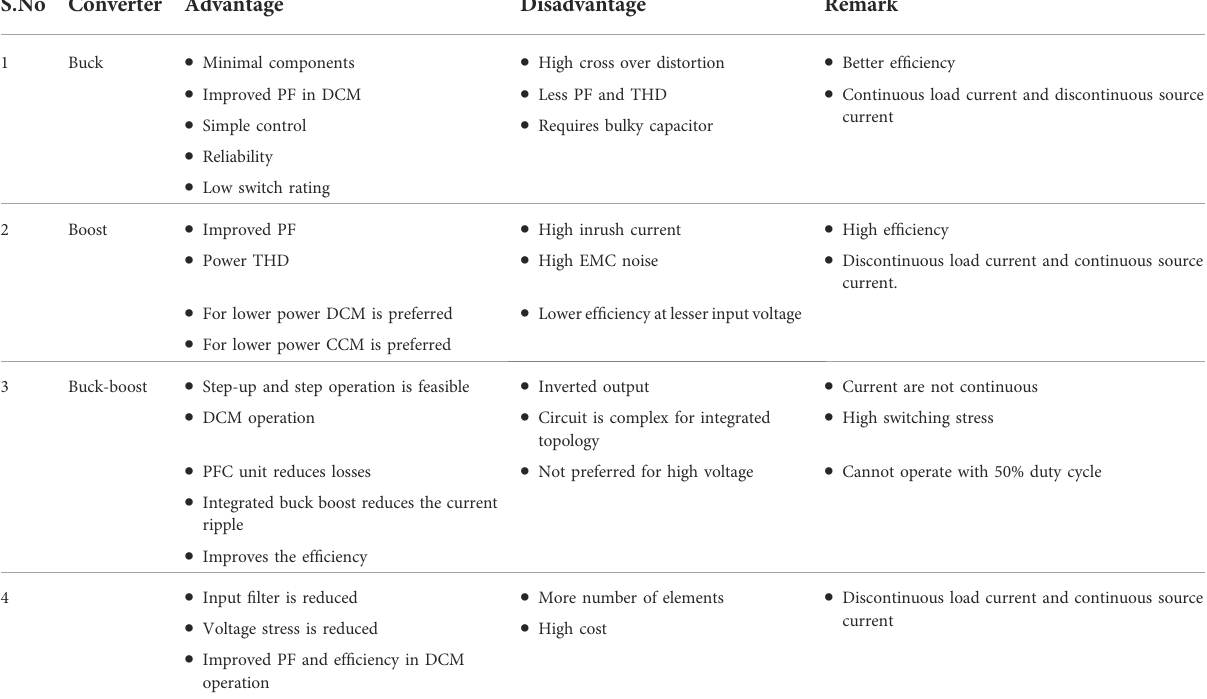
TABLE 5 Summary of various LED isolated